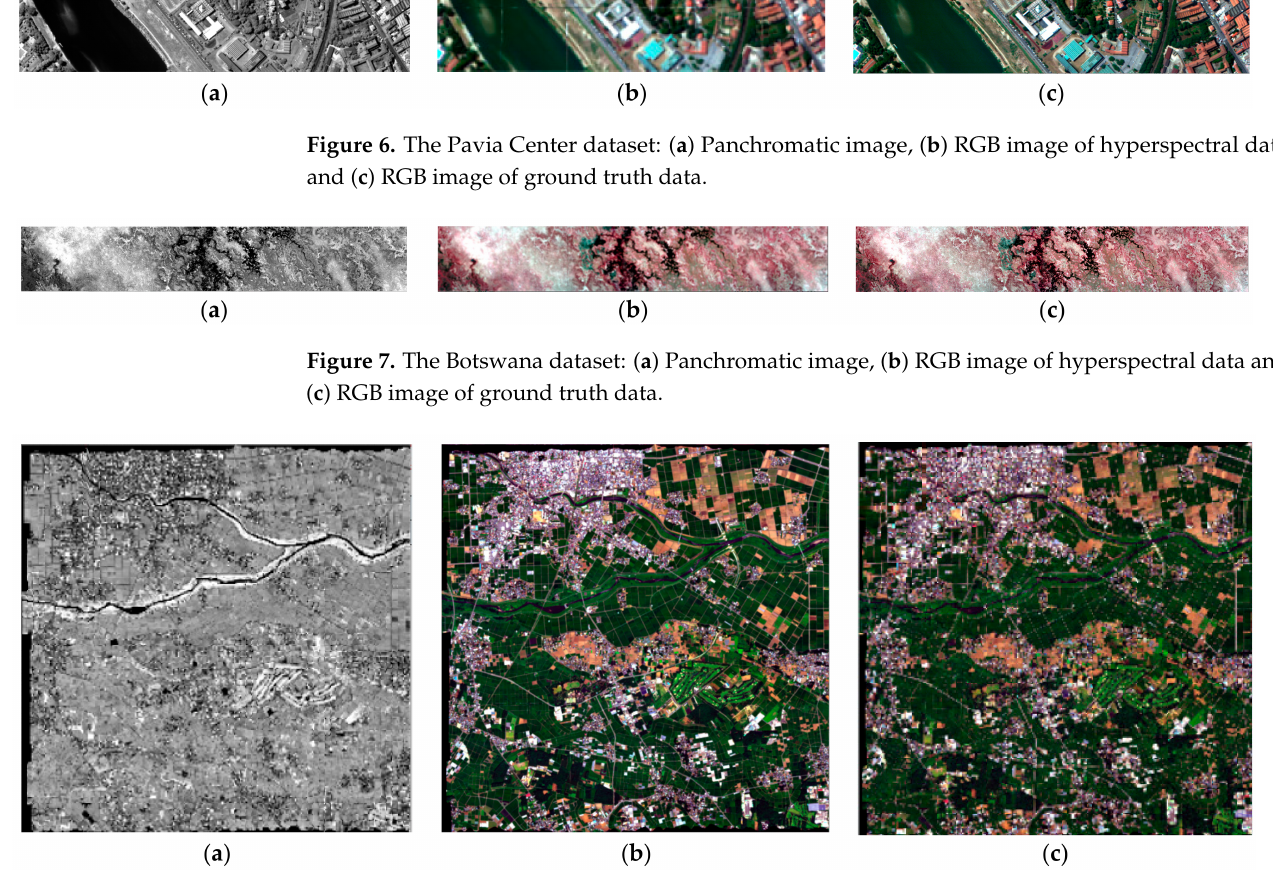
Figure 8. The Chikusei dataset: ( a ) Panchromatic image, ( b ) RGB image of hyperspectral data and ( c ) RGB image of ground truth